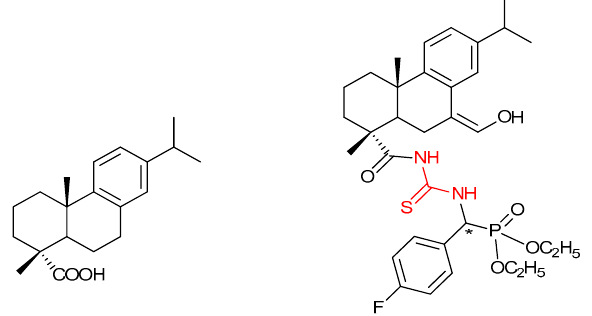
Figure 41. Dehydroabietic acid and its most active thiourea derivative [379].